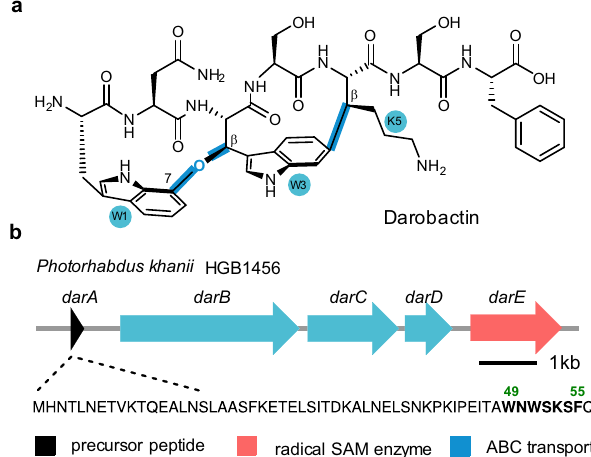
Fig. 1 Darobactin and its BGC. a The chemical structure of darobactin. The key C – O – C and C – C crosslinks that consist the unique bicyclic scaffold of darobactin are highlighted in blue. b The darobactin BGC from Photorhabdus khanii HGB1456 encodes a precursor peptide DarA pk , an rSAM enzyme DarE pk , and three ABC transports DarBCD pk . The core sequence of DarA pk (DarA pk(49-55) ) is shown in